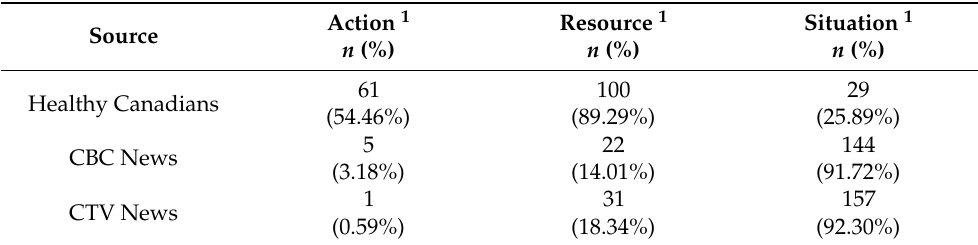
Table 5. Number and percentage of Facebook posts incorporating topics for Healthy Canadians, CBC News, and CTV News.